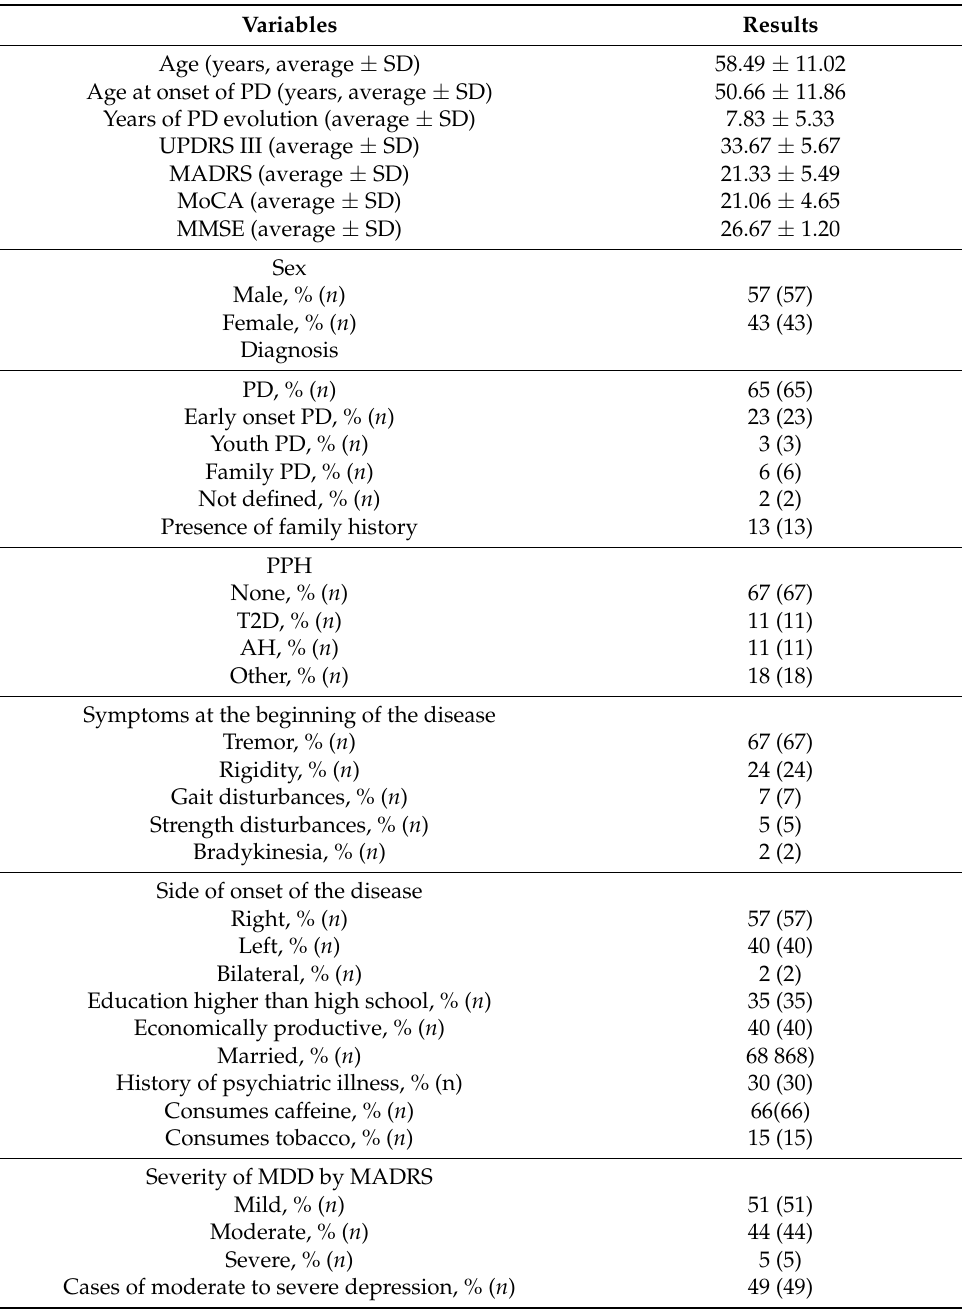
Table 1. Sociodemographic variables of the general sample ( n =